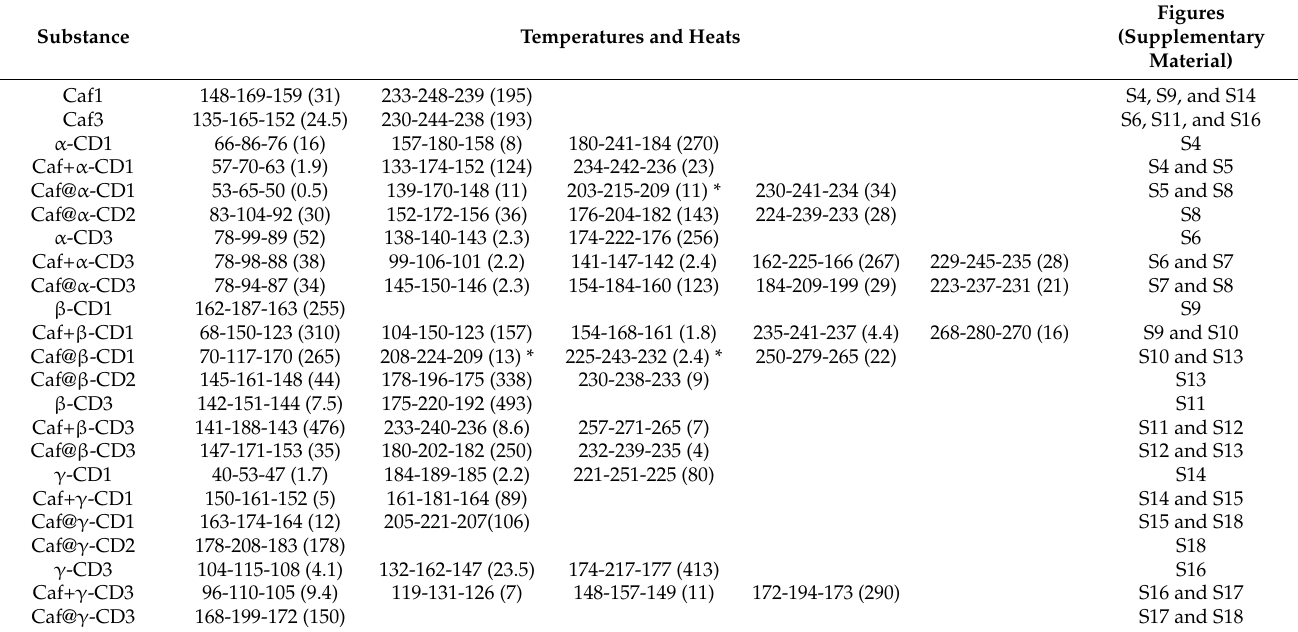
Table 2. The initial, final, and maximum (i-f-m) temperatures ( ◦ C) of the DSC peaks, with the respective ∆ H values (J · g − 1 , in